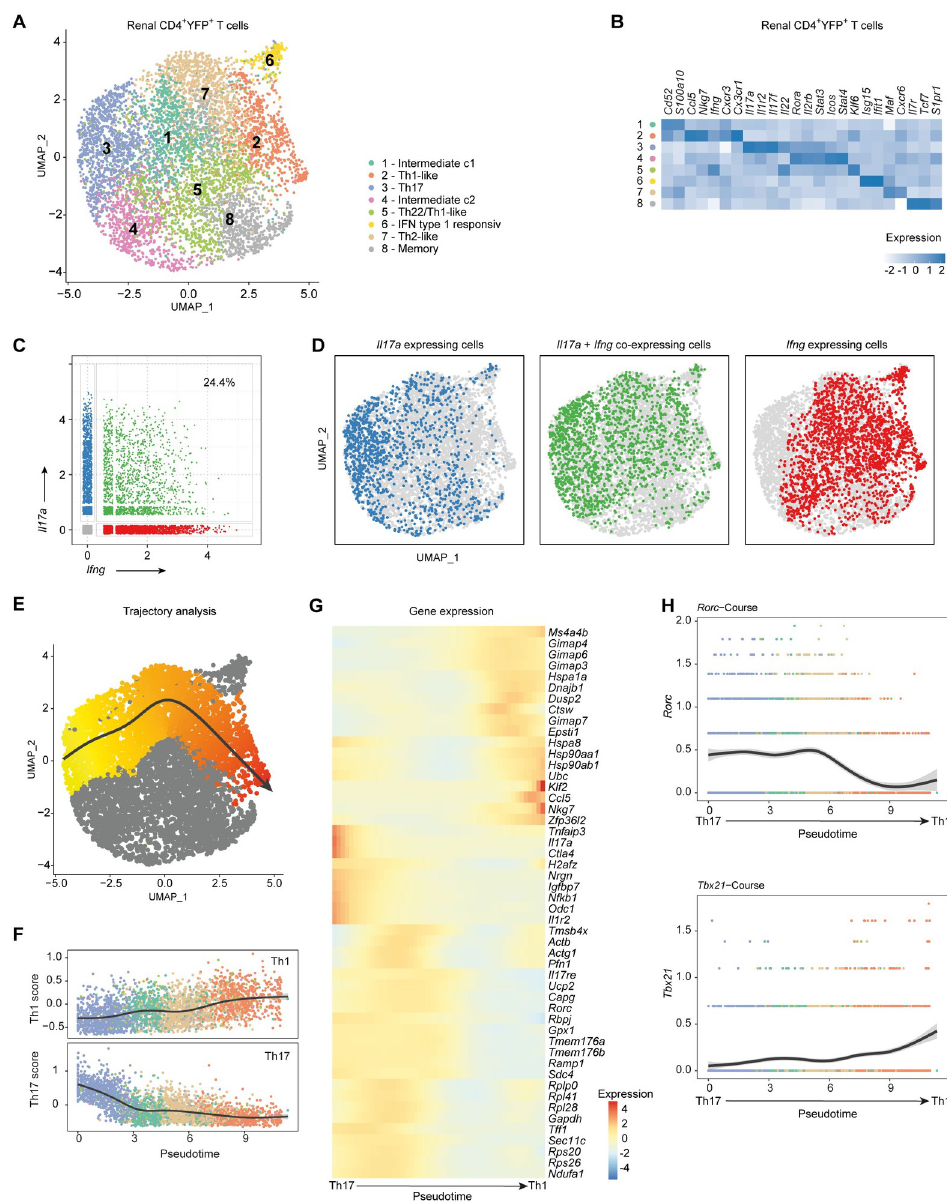
Fig 4. Comprehensive gene expression analysis of Th17 cells in S . aureus sepsis. (A) UMAP visualization and (B) Differential gene expression of renal YFP + CD4 + T cells 10 days after S . aureus infection of Il17aCre x R26eYFP fate reporter mice (pooled cells from n = 5) analyzed by single cell RNA-sequencing. (C) Il17a and Ifng expression of renal YFP + CD4 + T cells 10 days after S . aureus infection of Il17aCre x R26eYFP fate reporter mice (pooled cells from n = 5 mice). (D) Feature plot of Il17a and/or Ifng -expressing cells. (E) Trajectory of Th17 to Th1-like cells and (F) the Th17 and Th1 score over pseudotime; the line was fit to a generalized additive model. (G) Gene expression of the top 50 genes associated with Th17 to Th1-like trajectory at 50 timestamps over pseudotime, especially of (H) Rorc and Tbx21 . T-bet-deficiency affects Th17 to Th1 transdifferentiation in infected kidneys Tbx21 /T-bet was upregulated in Th17 fate cells that transdifferentiated into Th1 phenotypes. To evaluate the impact of T-bet on Th17 cell transdifferentiation, we made use of S . aureus -